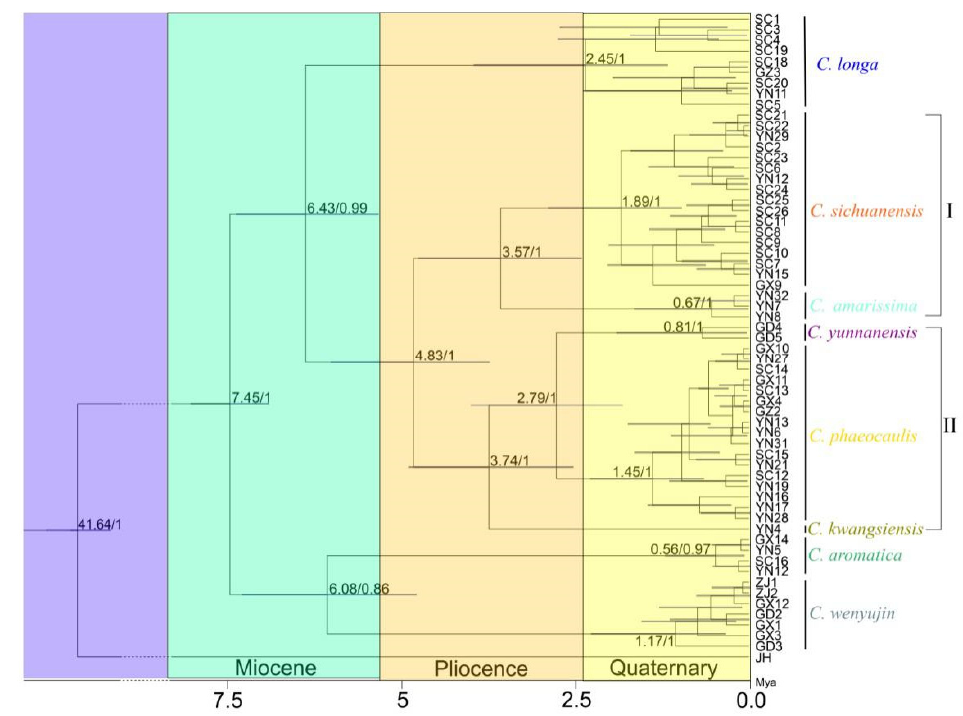
Figure 4. Phylogeny tree resulting from the Bayesian inference and divergency time of Chinese Curcuma in BEAST (Divergence time/Bayesian support). Group I consisted of C. amarissima , C. sichuanensis , C. kwangsiensis , C. yunnanensis, and C. phaeocaulis . Group II was made up of C. kwangsiensis , C. yunnanensis, and C. phaeocaulis.